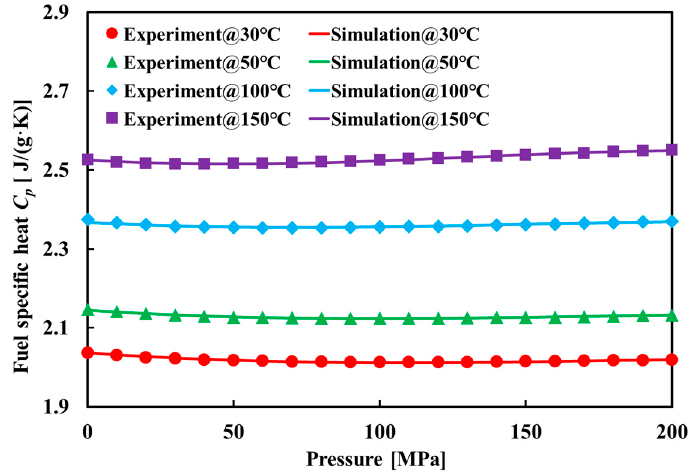
Figure 6. Cp calculated with Equation (2) compared with experimental data from [23].